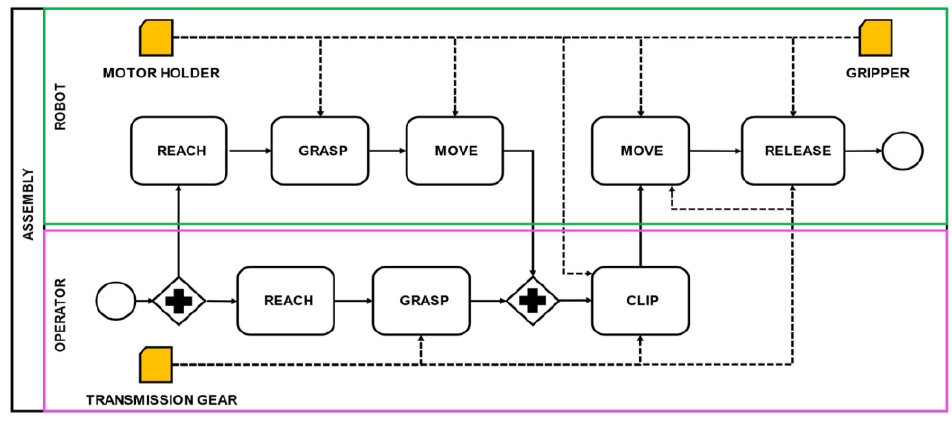
Figure 6. BPMN workflow of the assembly procedure.